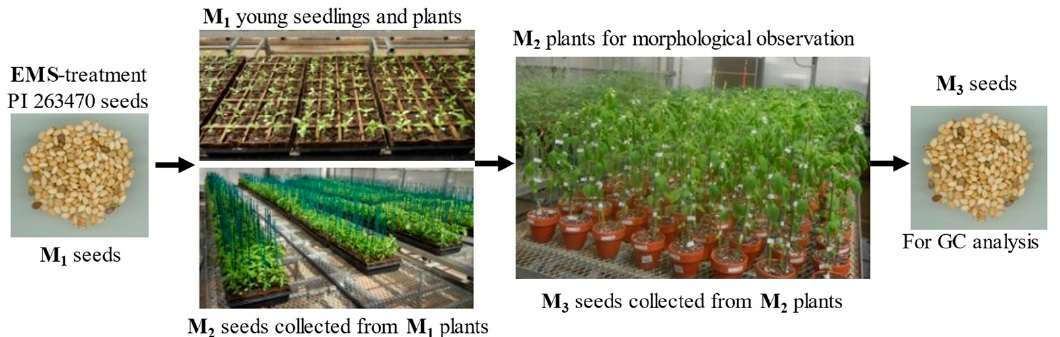
Figure 3. The procedure of mutagenesis from M 1 seeds to M 3 seeds.